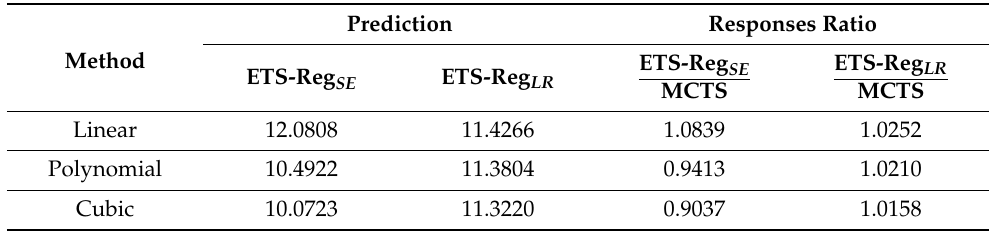
Table 3. ETS-Regression of different empirical models in calculating the P 100 -year short-term responses for total base shear quasi-static responses and without current. H s = 15 m (P 100 MCTS = 11.1459 mega Newton (MN)).